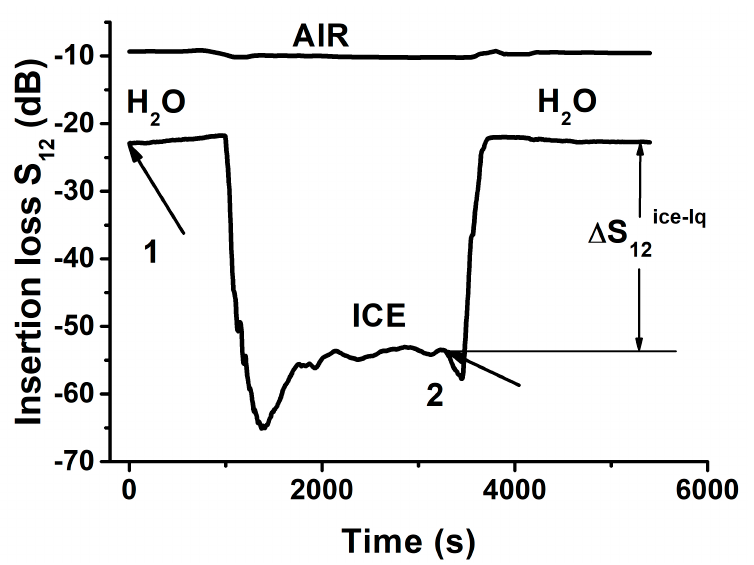
Figure 5. Time variation of the insertion loss S 21 of the delay line coated with distilled water measured for jump cooling (from +20 °C to − 15 °C, arrow 1) and jump heating (from − 15 °C to +20 °C, arrow 2). AIR: the measurements without liquid. H 2 O-ICE-H 2 O: the measurements with water and ice. Plate: Y,Z-LiNbO 3 , h / λ = 1.67. Mode: f n = 38.4 MHz. The position of the water (ice) sample on the plate is shown in Figure 2a.